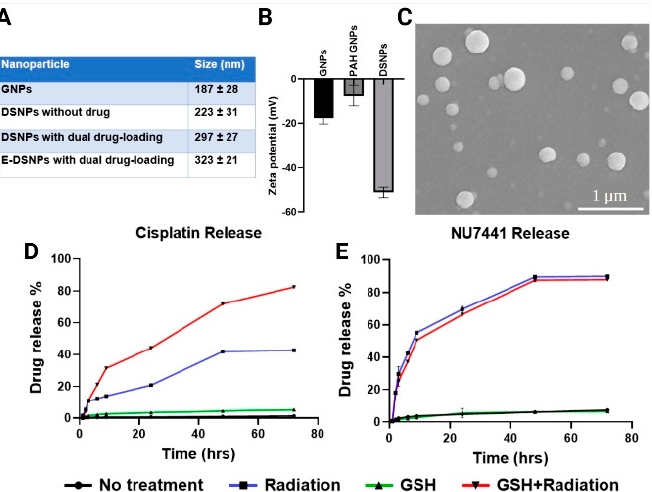
Figure 2. In vitro characterization of E-DSNPs. ( A ) Dual drug-loaded E-DSNPs exhibited hydrodynamic diameter up to ~300 nm. ( B ) Zeta Potential change of the NPs during different layers. ( C ) SEM imaging observed a spherical morphology of the NPs. ( D ) Exposure of E-DSNPs to combined radiation and GSH permitted elevated Cisplatin release from the core of the NPs, compared to that by radiation alone. ( E ) E-DSNPs exhibited higher NU7441 release from the shell, when exposed to combined GSH and radiation than by radiation alone. Exposure to GSH alone did not have any effect on the drug release characteristics of Cisplatin or NU7441.